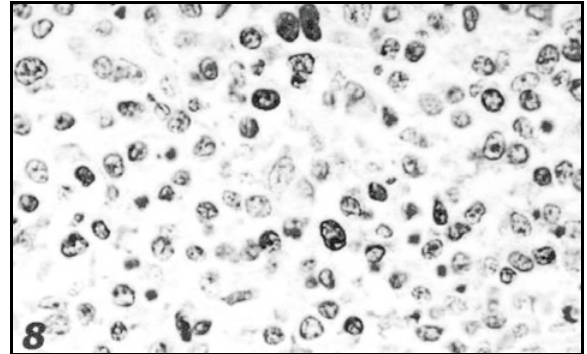
Figure 4 – Melanoma, anti-S100 protein, cytoplasm staining, (x 400)